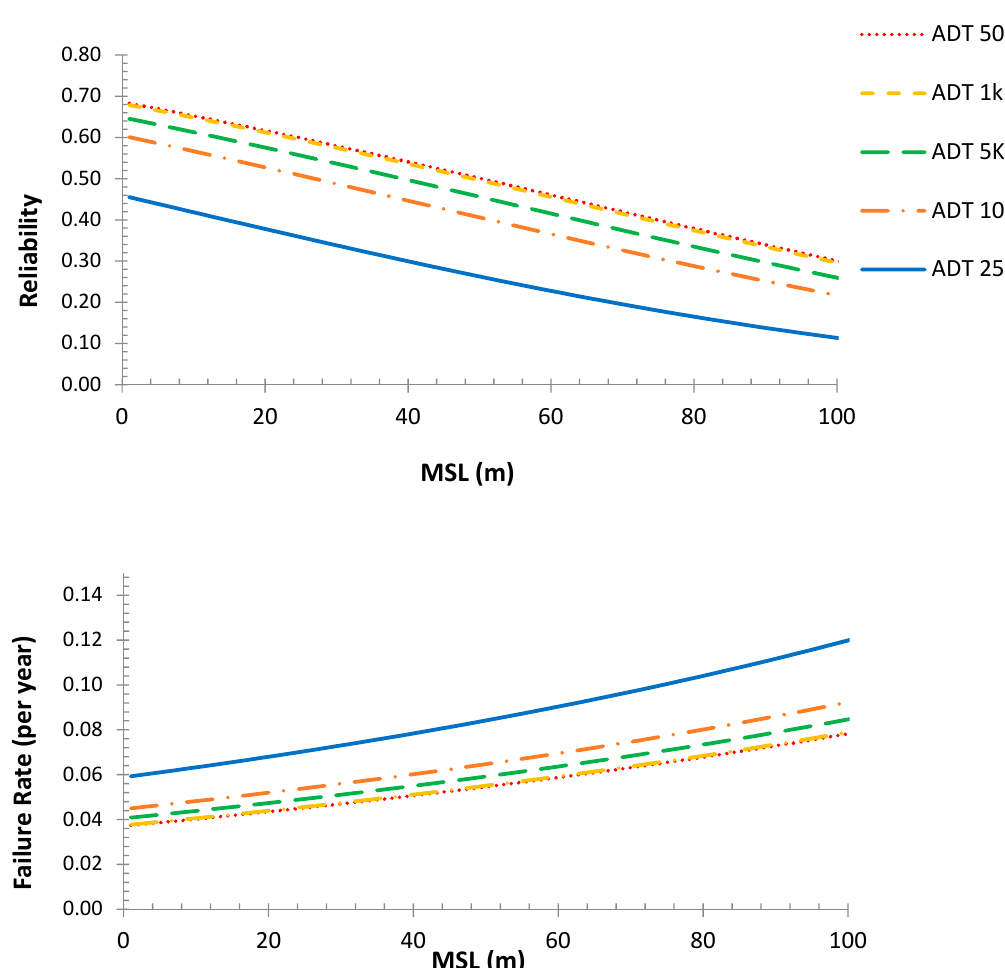
Figure 5. Superstructure reliability and hazard rate versus MSL with different ADT values at the age of 50 years (All superstructure types).